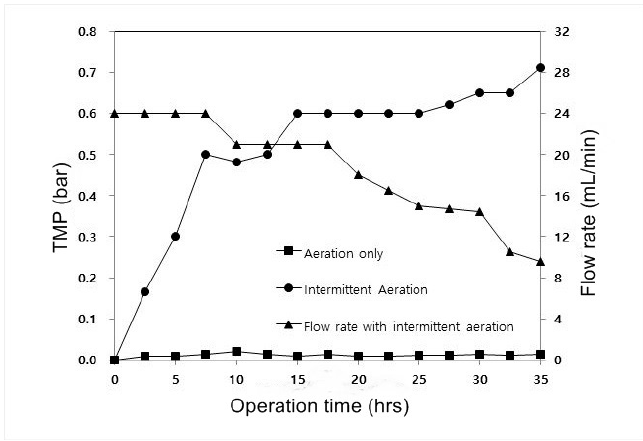
Figure 2. Trans-membrane pressure (TMP) profiles and flow rates of effluent under continuous aeration or intermittent aeration in MBRs.